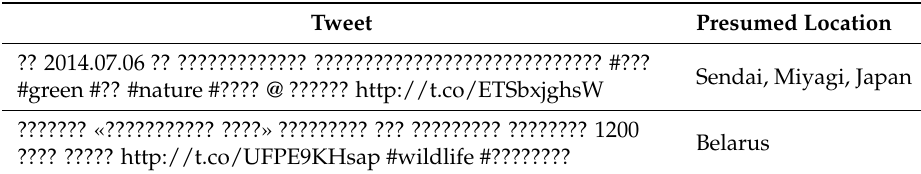
Table 5. Tweets without recognizable text.